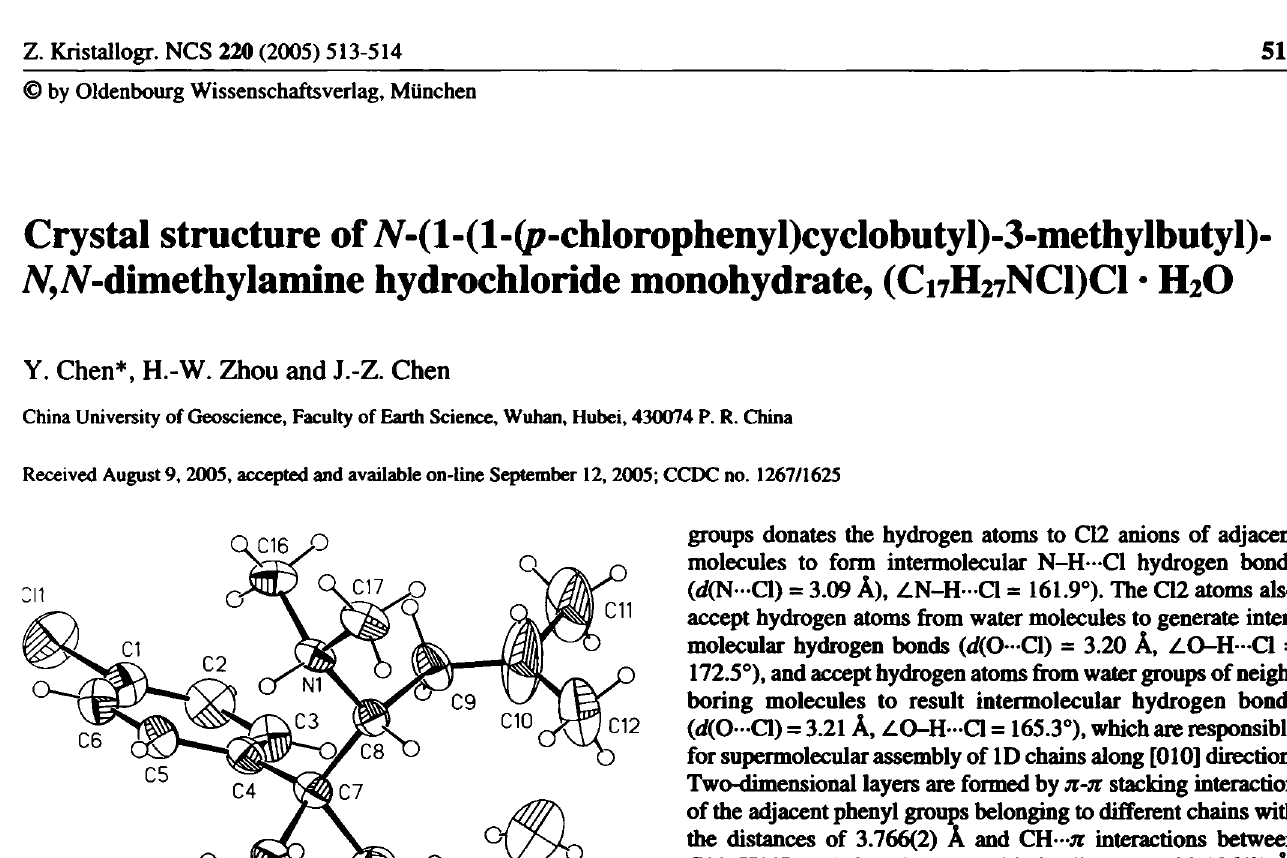
Table 1. Data collection and handling.